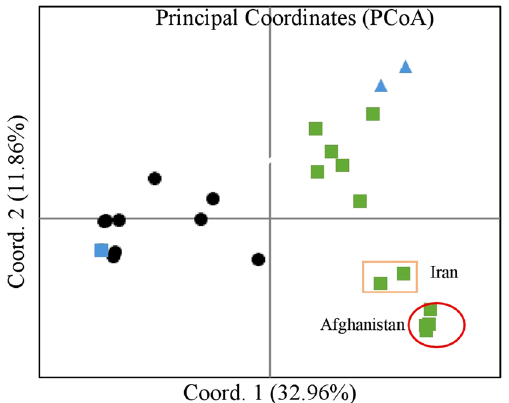
Figure 2. Principal Coordinate analysis of 26 lines Genotyped by 83 KASP markers representing the AABB genome. Panel of 24 spelt lines and two bread wheat cultivars (see supplementary S1 labelled as star mark). Modern bread wheat (blue triangle) Free-threshing spelt (green rectangle) Hulled spelt (filled circle). GenAlEx 6.503 47 was used to calculate binary genetic distances between genotypes. Principal coordinate analysis (PCoA) was used to illustrate genetic distances.